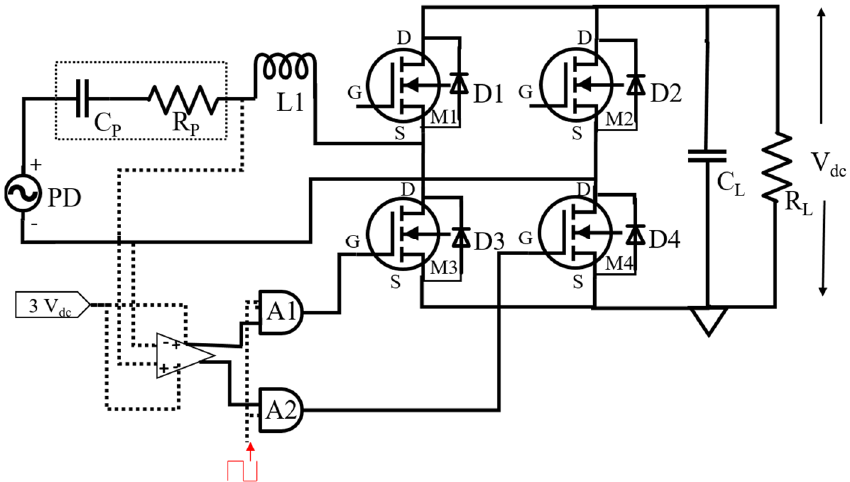
Figure 5. Schematic of the proposed INLSC (M1–M4: MOSFET switches, G: Gate, D: Drain, S: Source, A1, A2: Logic